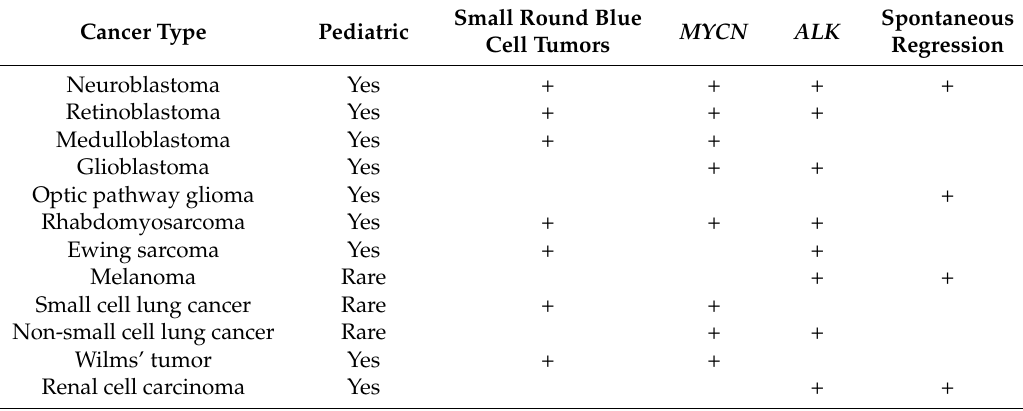
Table 4. Similarities among neuroblastoma and other pediatric solid tumors. A cancer is marked pediatric if it has high incidence among all children with cancer, or has high pediatric incidence relative to adult. Small round blue cell tumors are cancers with a similar histologic appearance (highly nucleated, mesenchymal) that are often difficult to distinguish, especially in pediatric patients. If a subset of patients present with mutations or amplifications, a cancer is marked as being MYCN or ALK modified. While spontaneous regression is a rare event in all cancers, some experience slightly higher rates of treatment-independent full or partial regression of tumors and are included in the table as experiencing “spontaneous regression.” (*) Spontaneous regression cases of retinoblastomas may actually be benign retinomas, and therefore misclassified [96,97,140–154]. Spontaneous Small Round Blue Cancer Type Pediatric Cell Tumors